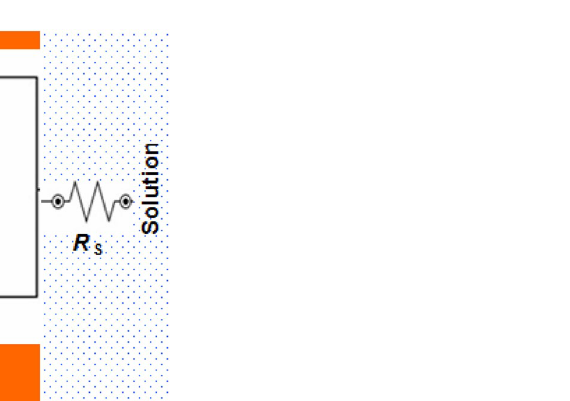
Figure 6. Equivalent circuit to fit the impedance coated 303 SS by the neat PANI and PANI/Zn-Pr composite (0.5% Zn-Pr) in 1.0 M H 2 SO 4 solution.